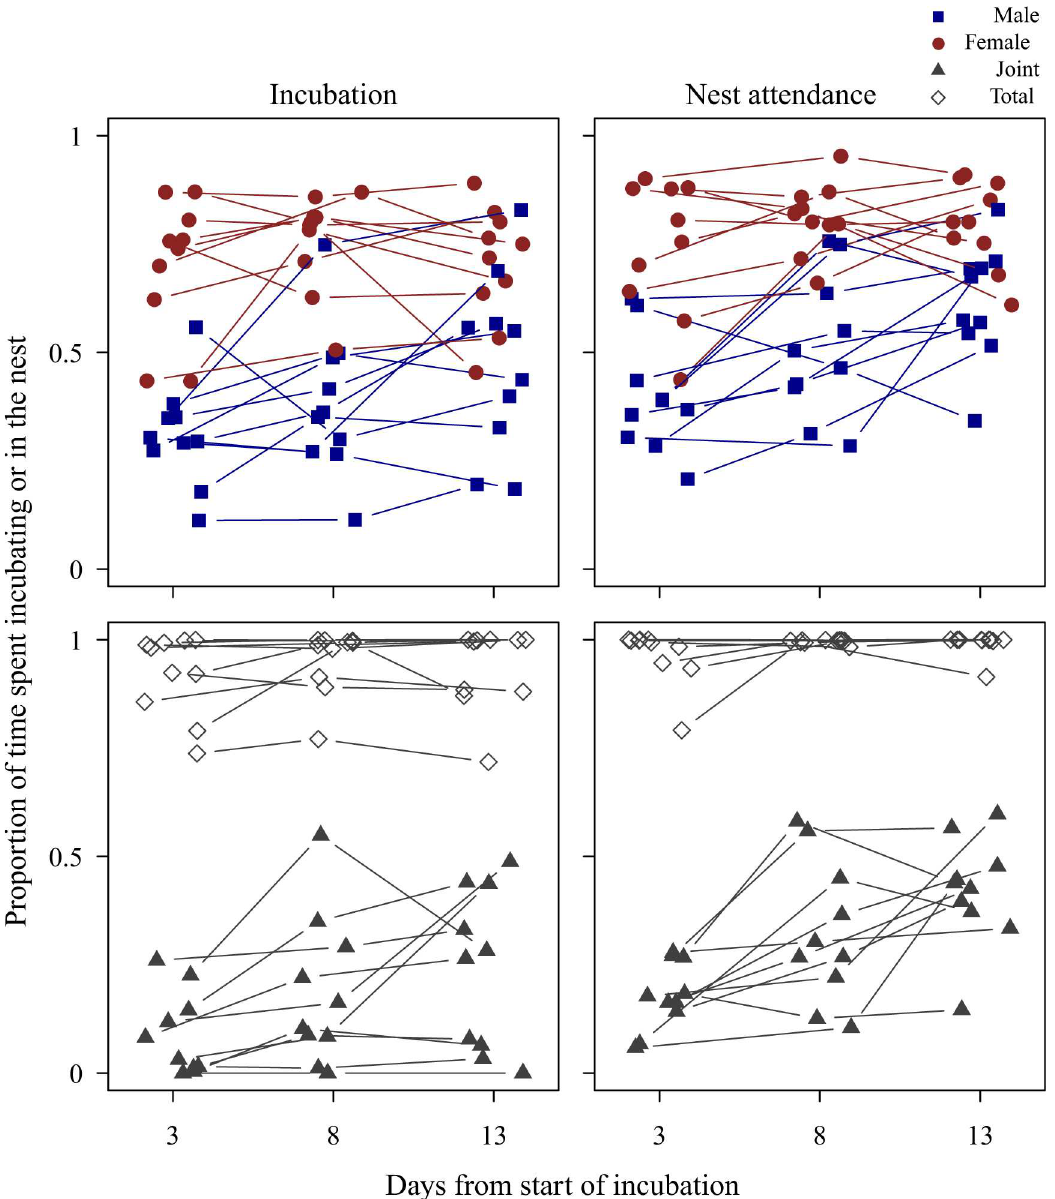
Fig 2. Division of labour and individual variation of parental effort in zebra finches during incubation. The figure shows proportionof 3h observation periods (10:00–13:00) spent incubating and inside the nest (nest attendance) during early, middleand late incubation(day 3, 8 and 13 of incubation, respectively). Blue filled squaresrepresent male, red filled circles female, grey filled trianglesjoint (male and female simultaneous) and grey open diamonds total parentaleffort (when at least one parent incubatesor attends the nest). Data from the same individualsare connected with